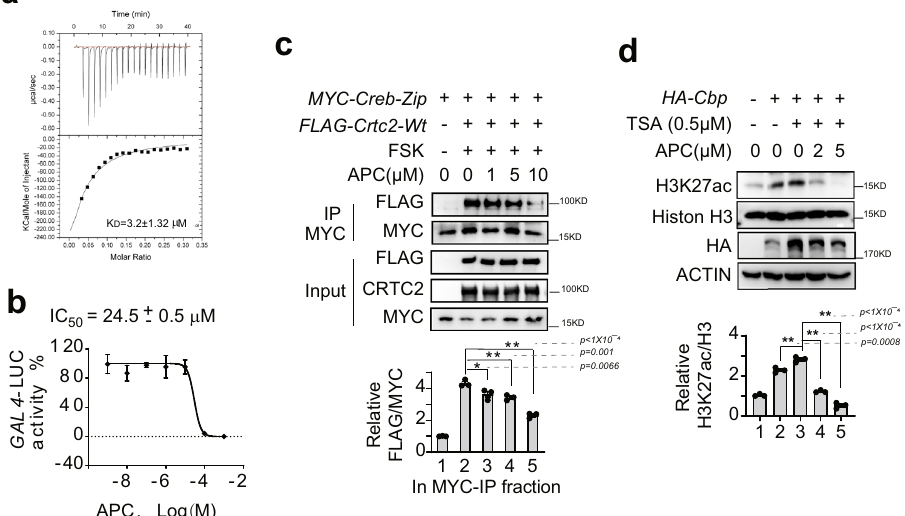
Fig. 3 APC inhibits CRTC2 interacting with CREB-ZIP and reduces acetyltransferase activity of CBP by binding with CREB protein directly. a Isothermal titration calorimetry (ITC) of HIS-CREB protein solution titrated into APC solution. The bottom solid line represents a nonlinear least-squares fi tted by a single-site binding model. One of two independent experiments is shown here. b IC 50 of APC inhibitory activity detected by CREB – CRTC2 two-hybrid assay in HEK293T cells ( n = 3 per treatment, data are represented as mean ± SEM). One of three independent experiments is shown here. c Immunoprecipitation analysis of FLAG-CRTC2-WT recovered by anti-MYC antibody from HEK293 cells co-transfected with plasmids for a Myc-Creb-Zip fragment and the FLAG- Crtc2-Wt , stimulated by FSK (10 nM) for 2-h before harvest. APC (1 – 10 μ M) was included in immunoprecipitation mixtures as indicated. Top represents one of three independent experiments, and the relative gray density of FLAG normalized to MYC in MYC-IP- factions is shown as a bar graph (bottom, n = 3). Data are represented as mean ± SEM; P values were determined by one-way ANOVA followed Dunnett ’ s multiple comparisons test. d Immunoblotting analysis of the acetyltransferase activity of CBP. The protein levels of H3K27ac and total Histone H3 were determined using speci fi c antibodies from HEK293 cell lysate overexpressing HA-Cbp plasmid. Pretreatment with trichostatin (TSA, 0.5 μ M) for 1 h prior to incubation with APC (2, 10 μ M) for another 2-h. The top represents one of three independent experiments, and the relative gray density of H3K27ac normalized to total Histone H3 in cell lysate is shown as a bar graph (bottom, n = 3). Data are represented as mean ± SEM; P values were determined by one-way ANOVA followed Dunnett ’ s multiple comparisons test. ns, P > 0.05; * P < 0.05; ** P < 0.01. Sources data for this fi gure are provided as source data fi